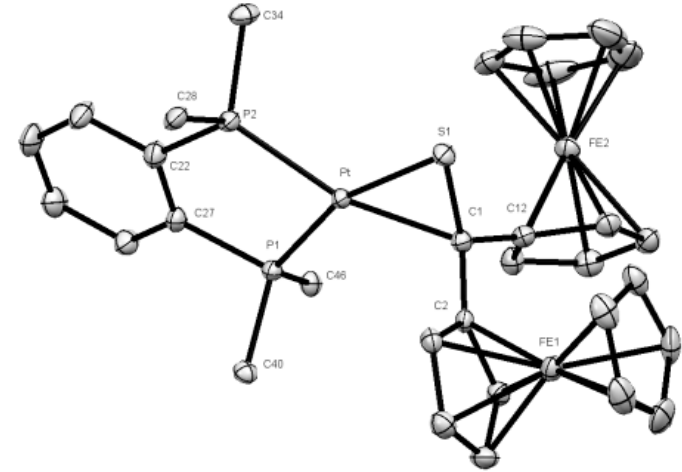
Figure 3. Molecular structure (50% probability) of complex 3a . Hydrogen atoms, solvent molecule (toluene), as well as the phenyl rings of the dppbe ligand are omitted for clarity. The bond lengths Pt-S(1) [2.3014(8) Å], S(1)-C(1) [1.791 (3) Å], and Pt-C(1) [2.155(3) Å] (see Table S1) are comparable with values reported for analogous platinathiiranes containing the same bisphosphane ligand [18,47]. The same method was used for the preparation of platinathiiranes 3b and 3c starting with 1a and Pt(0) complexes 2b and 2c , respectively. The structures of complexes 3b and 3c were also established by means of spectroscopic methods as well as by XRD analysis (Figure 4).